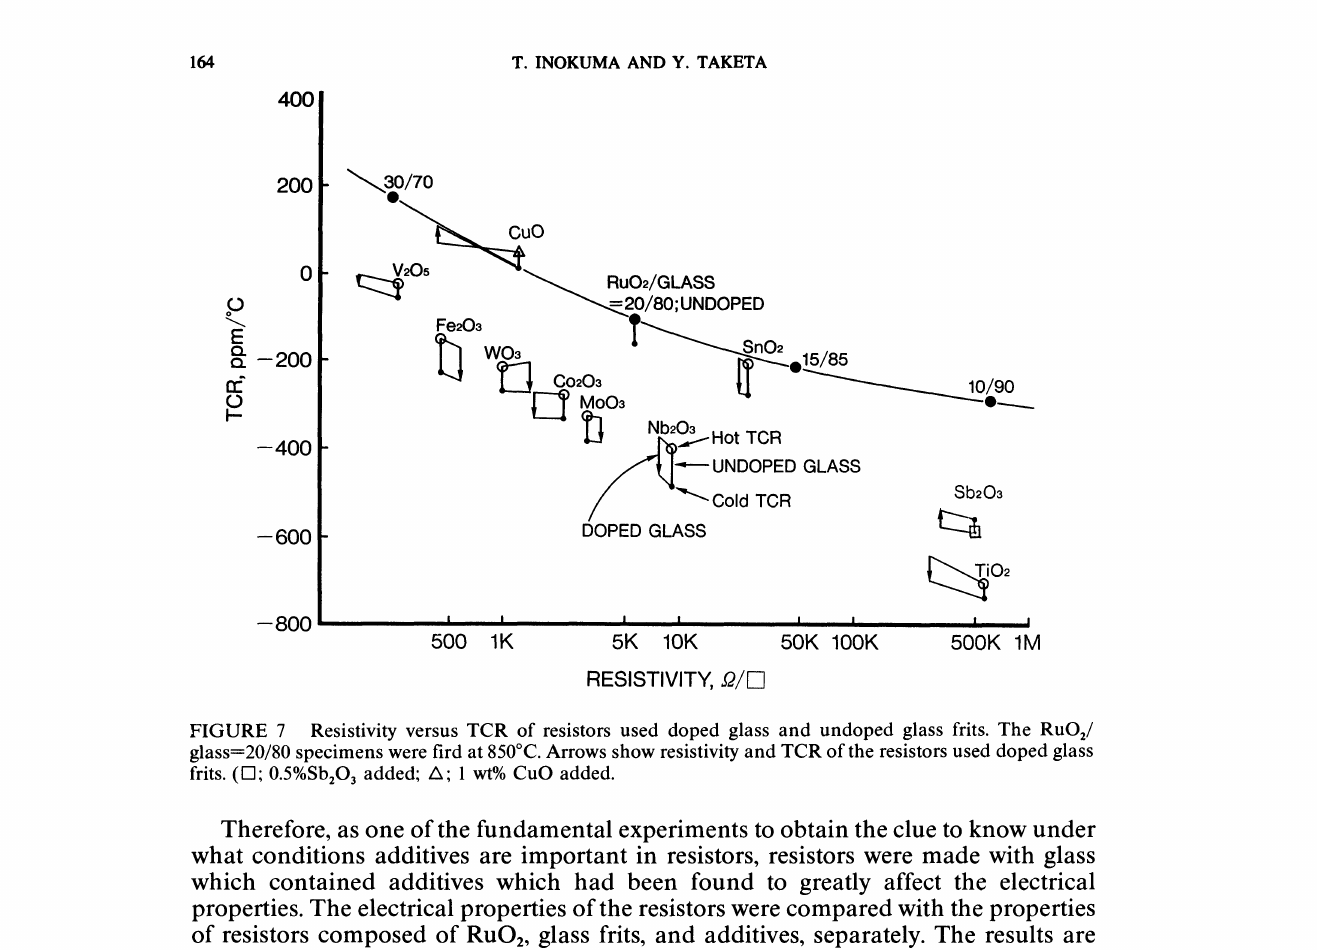
FIGURE 7 Resistivity versus TCR of resistors used doped glass and undoped glass frits. The RuO2/ glass=20/80 specimens were fird at 850C. Arrows show resistivity and TCR of the resistors used doped glass frits. ([]" 0.5%Sb203 added; A; wt% CuO